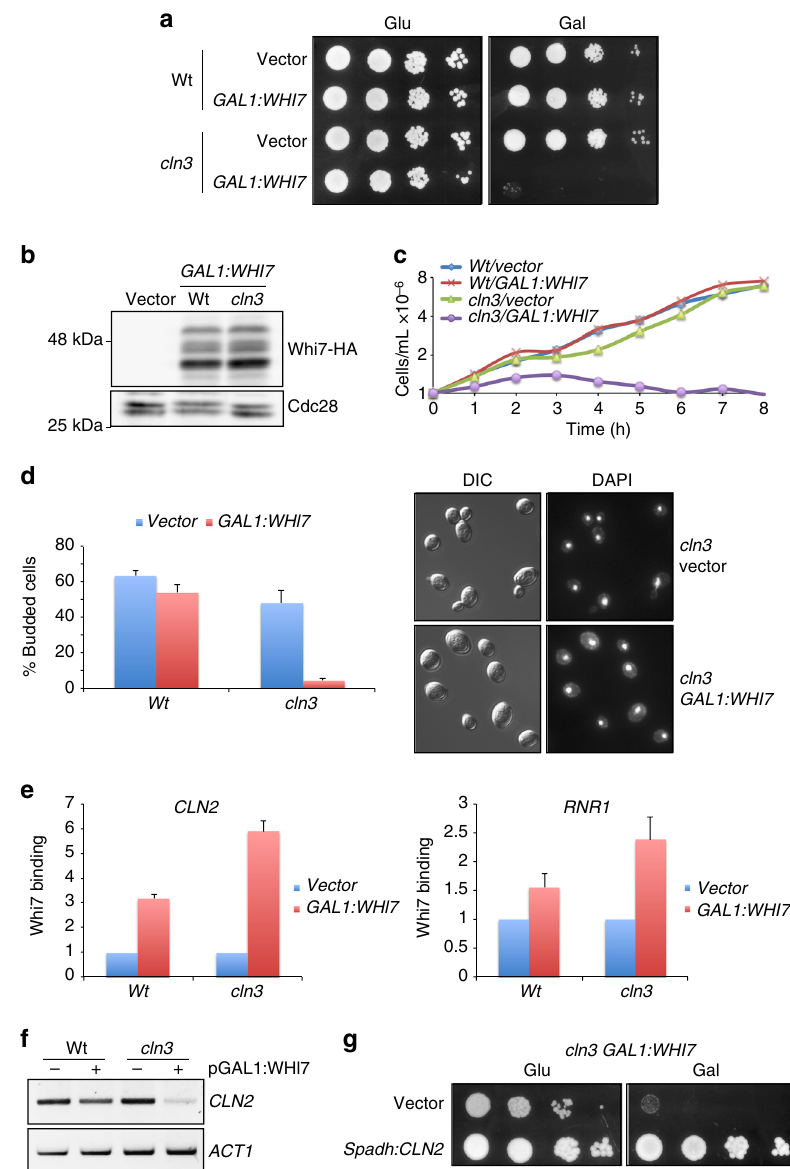
Fig. 6 Effect of WHI7 overexpression in cell cycle progression in a cln3 mutant strain. a 10-fold serial dilutions from cultures of wild-type (W303) and cln3 mutant (MT244) strains transformed with an empty vector or the pGAL1:WHI7 plasmid, were spotted onto SC-Glu and SC-Gal medium and incubated at 25 °C for 3 days. b Western blot analysis of Whi7 protein level in cells grown on SC-Gal medium. c The same strains were grown on SC-Raf. Galactose to 2% was added to induce overexpression of WHI7 and the increase in cell number was analyzed. d Cell cycle distribution of cells after 3 h since the addition of galactose. Plot represents percentage of budded cells. Pictures show DIC image and DAPI staining of DNA. e Whi7 association with CLN2 and RNR1 promoters was investigated by ChIP assays after 3 h since the addition of galactose. f The level of CLN2 and ACT1 mRNA was analyzed by semiquantitative RT-PCR after 3 h since the addition of galactose. g 10-fold serial dilutions from cultures of the cln3 mutant strain (MT244) transformed with pGAL1:WHI7 and either a vector or a plasmid expressing CLN2 under the control of the adh promoter from S. pombe , were spotted onto SC-Glu and SC-Gal medium and incubated at 25 °C for 3 days. Values in d and e are the mean and s.d. derived from three